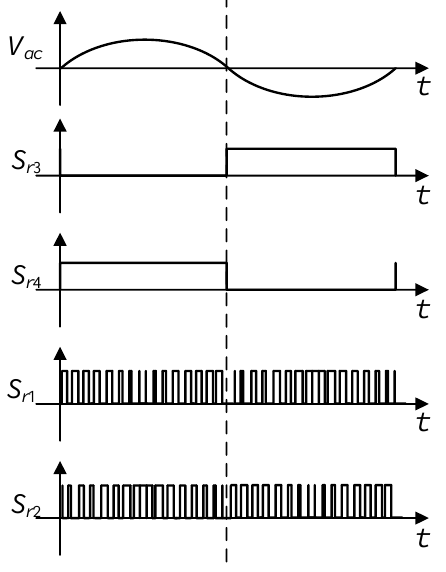
Figure 10. Control waveforms of the H-bridge inverter in TPCM.